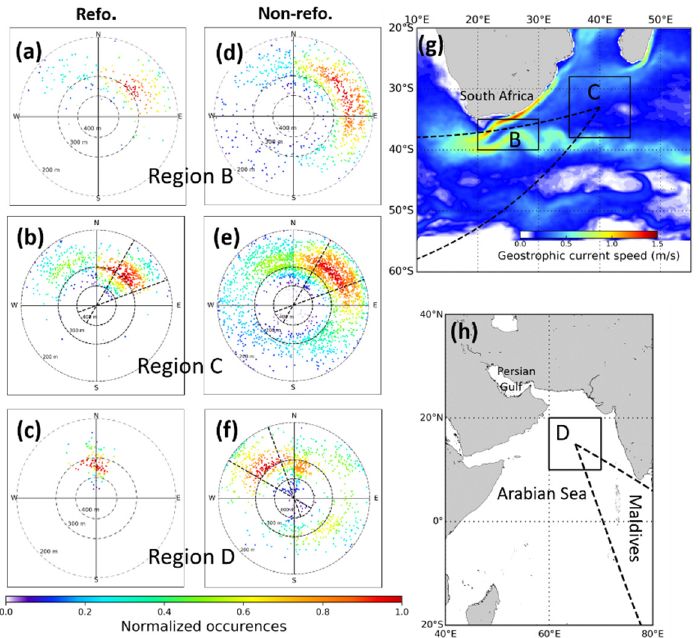
Figure 4. Spectral statistics of swell partitions from ( a – c ) refocused and ( d – f ) non-refocused ASAR WM spectra in “fireworks” for the Regions of B, C, and D. Maps for ( g ) Region B and C, with colors representing GlobalCurrent currents (2003–2012 average), and ( h ) Region D.